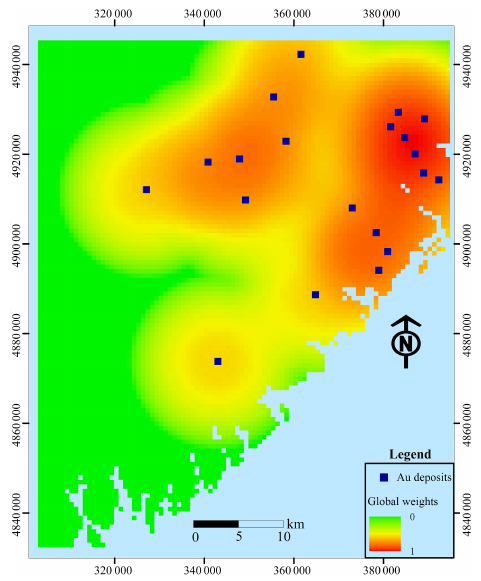
Figure 6. Exploration-level